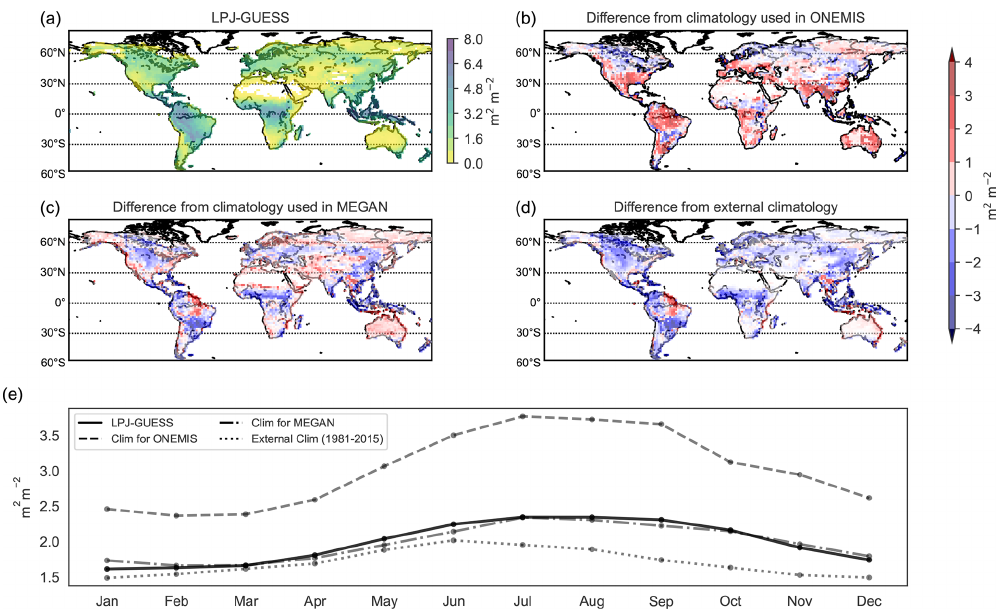
Figure 5. Geographic distribution of the LAI from LPJ-GUESS (a) and difference plots (LAI from LPJ-GUESS minus climatological LAI) from climatology used in the standard configuration in ONEMIS and MEGAN (panels b and c ). An additional LAI climatology from 1981 to 2015 is also included (d) . Panel (e) compares the global monthly averages of all datasets.